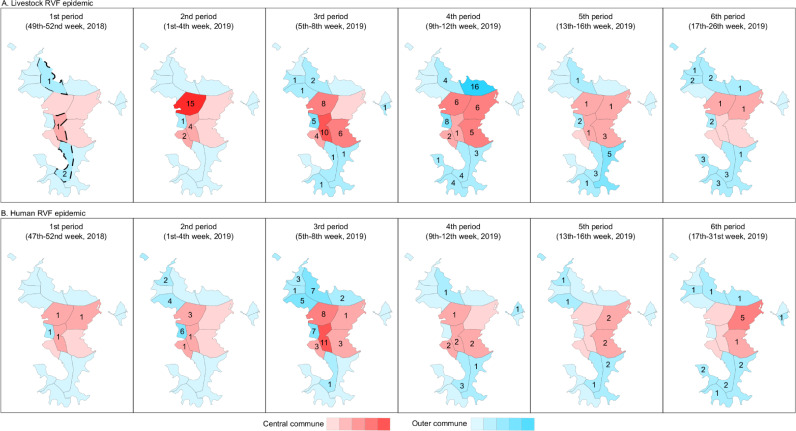
Spatio-temporal pattern of Rift Valley fever virus (RVFV) RT-PCR positive (A) animals and (B) humans. The epidemic was divided into five 4-week periods, and a sixth period comprised the last 15 weeks of the epidemic. The numbers on the map show the number of RVFV RT-PCR positive cases reported in each commune. Central communes are colored in red and outer communes in blue, with a darker shade representing a higher number of RVFV RT-PCR positive cases. Communes where RVFV was assumed to have been introduced into livestock (‘seeding communes’) are represented with a dashed border in the first map of Fig 3A.